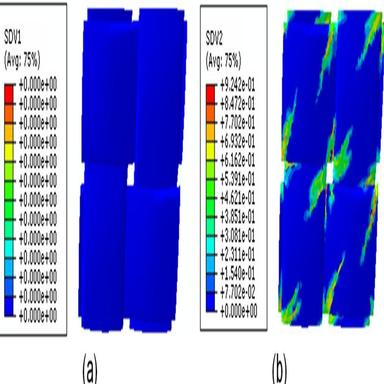
Damage contour of the yarn of FE_C model: (a) SDV1 damage; (b) SDV2 damage.